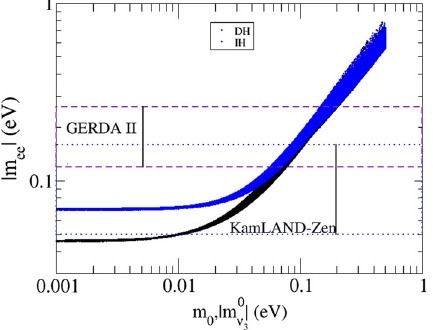
Fig. 5 Effectivemass | m ee | asafunctionofthecommonmass m 0 inthe case of degenerate hierarchy or of the lightest neutrino mass invertedhierarchy.Thehorizontalregionsdefinedbythebluedottedand purple dashed lines correspond to the limits by GERDA phase II [223] and KamLAND-Zen [224],